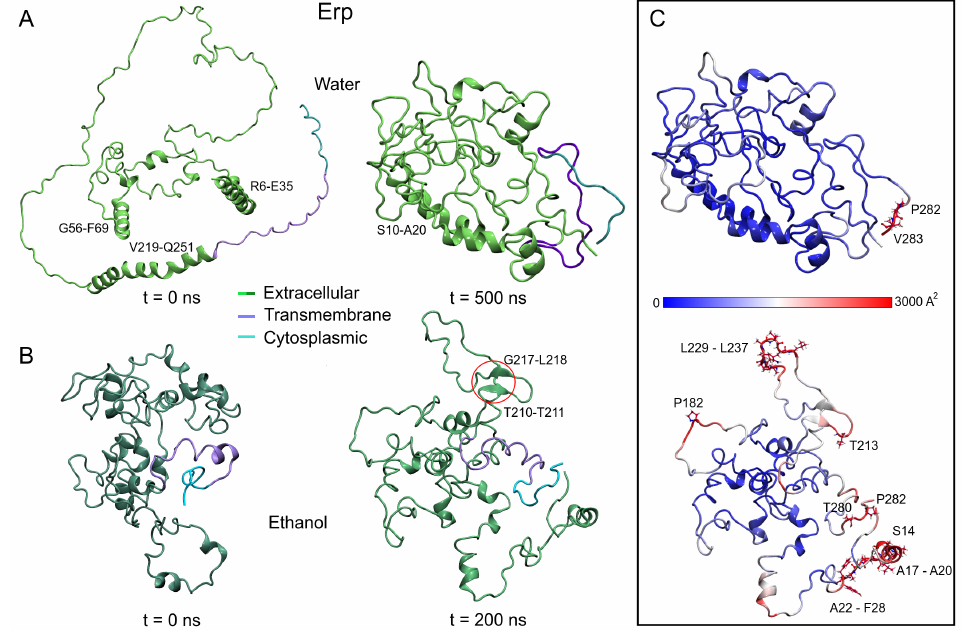
Figure 5. Erp structures at the initial and final of the MD trajectories. ( A ) Model retrieved of AlphaFold server. ( B ) Model built using the I-TASSER server. ( C ) B-factor values mapped on final MD structures. The high vibrational residues were depicted as a ball and stick and were labeled black. Since the Erp protein has intrinsically disordered domains, the size of the simulation boxes was revised to avoid interactions of the protein with its periodic images. Main domains are